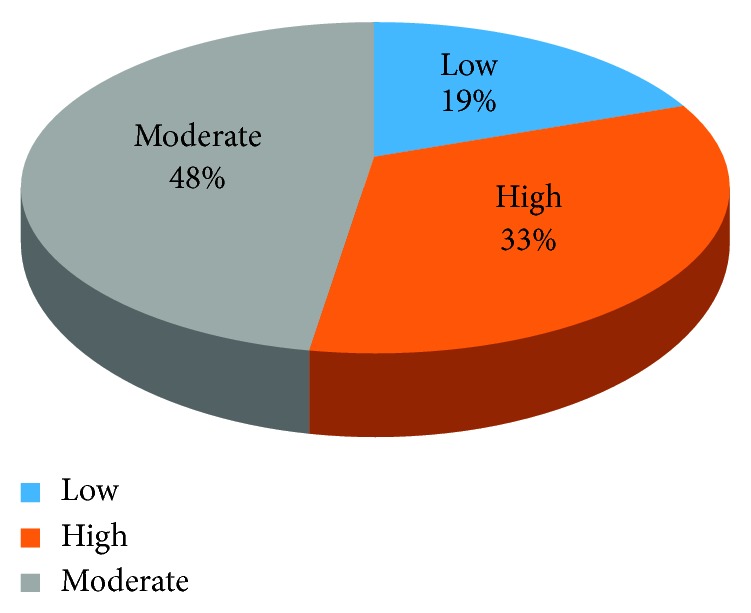
Overall level of preparedness for disease outbreak.